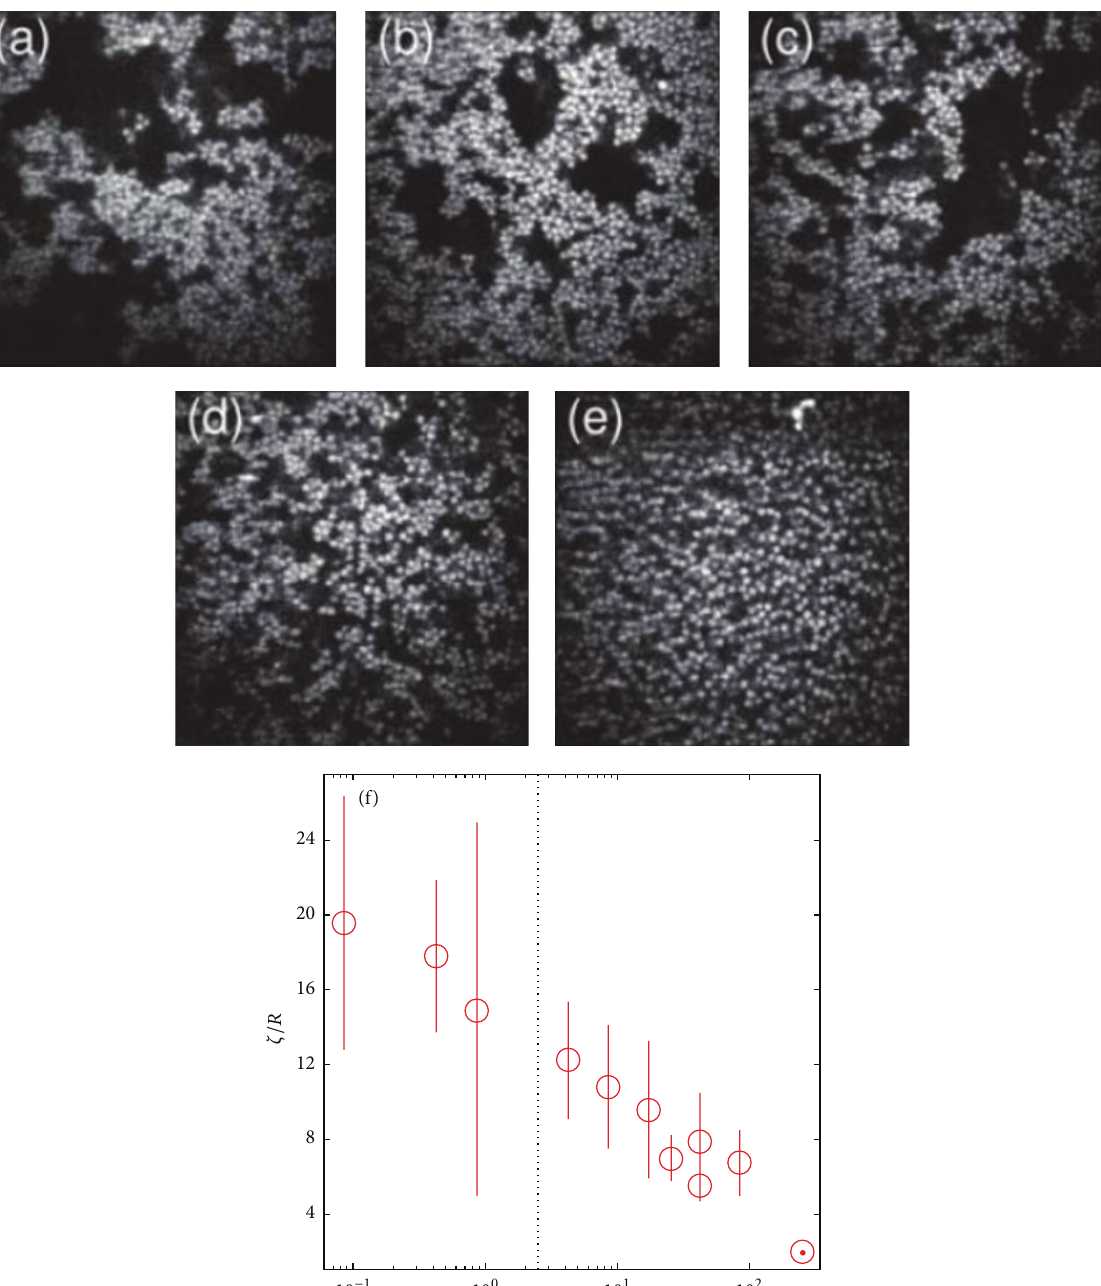
Figure 4: (a)–(e) Observations from confocal laser microscopy of a depletion flocculated particle system under shear, with, respectively, ̇𝛾 = 0.05 , 0.5, 1, 5, and 30 s −1 . (f) Nondimensionalised radius of clusters versus applied shear rate (as P´eclet number). The dotted line marks the onset of slip. For the system 𝑅 = 650 nm, 𝜑 = 0.4 , and 𝑈 0 = −20𝑘 B 𝑇 . (Reproduced from Ballesta et al. [102] with permission of The Royal Society of